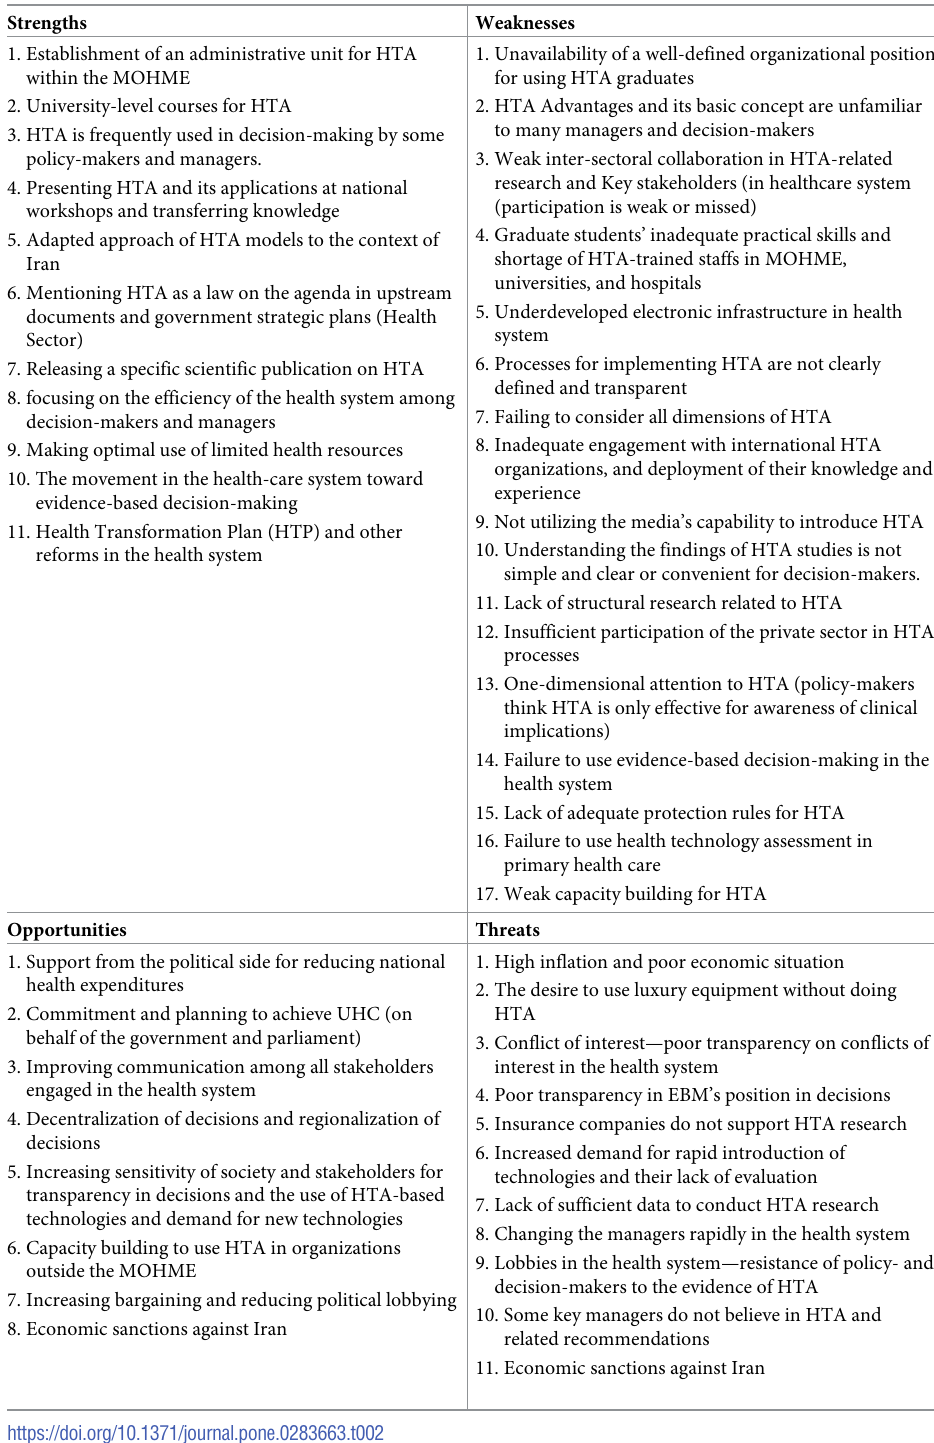
Table 2. Strengths, weaknesses, opportunities and threats of health technology assessment in